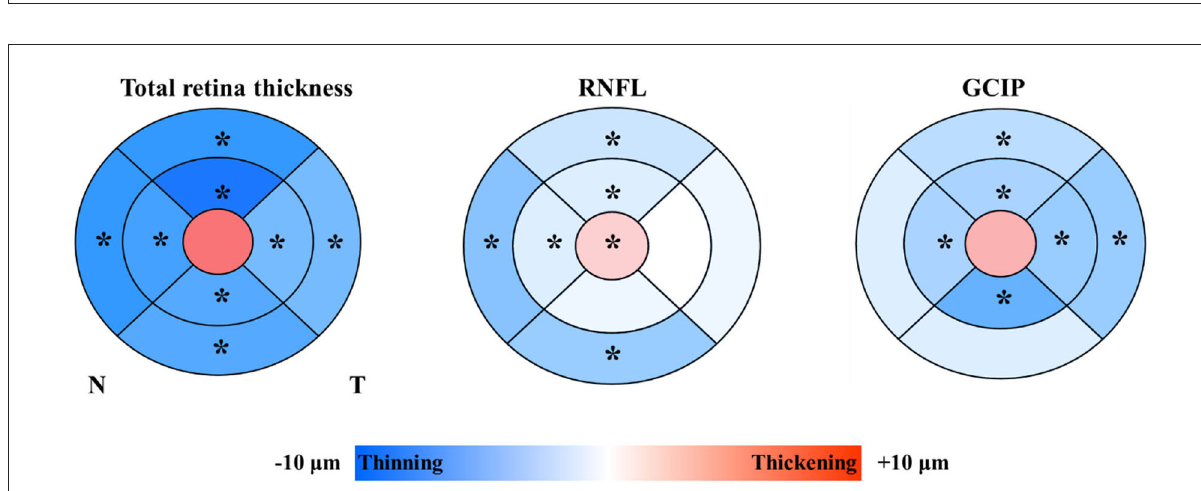
FIGURE3 Colorimetric differences in different subfields between the lower white matter hyperintensity volume group and the higher white matter hyperintensity volume group. In red, thickening; in blue, thinning. RNFL, retinal nerve fiber layer; GCIP, ganglion cell and inner plexiform layer. * P <